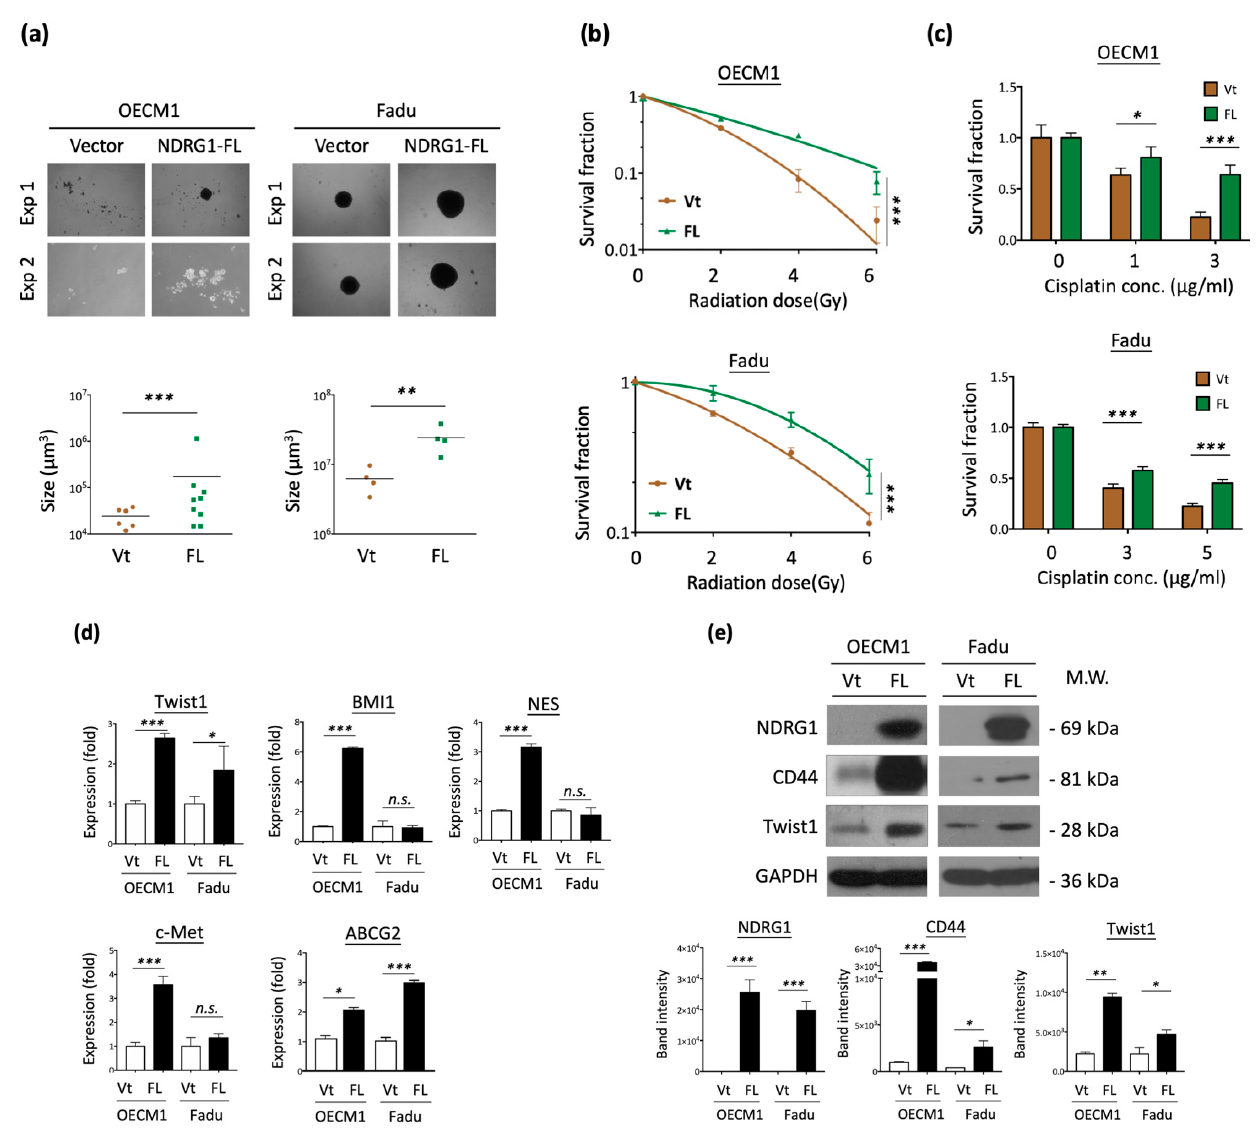
Figure 2. NDRG1 promoted cancer stemness by cancer stemness markers. ( a ) Spheroid cell formation was increased in NDRG1 overexpressed in HNC cells. After transfection of NDRG1-FL (FL) or the vector (Vt) plasmid into HNC cells (OECM1, FaDu), the effect of tumorsphere number and size was determined by microscope. ( b ) Overexpression of NDRG1-induced radioresistant ability in HNC cells, as determined by clonogenic survival assay. The error bars shown in the relevant figures indicate the standard deviation of the quantification results in the experiments. (*** p < 0.001; ANOVA test). ( c ) NDRG1 protected cisplatin-induced cell death, as determined by the MTS assay. ( d , e ) OECM1 and FaDu cells were transfected with NDRG1-FL or vector control and cells were collected for RT-qPCR analysis ( d ) or the cellular proteins were extracted and subjected to Western blot analysis and determination of protein expressions by antibodies ( e ). The GAPDH was used as an internal control. All the experiments were performed three times independently and typical results were shown. The error bars shown in the relevant figures indicate the standard deviation of the quantification results in all experiments. (* p < 0.05; ** p < 0.01; *** p < 0.001; n.s., no significance; t